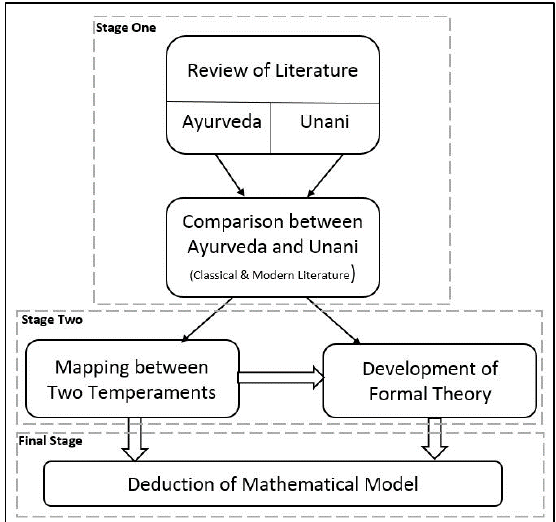
Figure 1. Three Stages Methodology